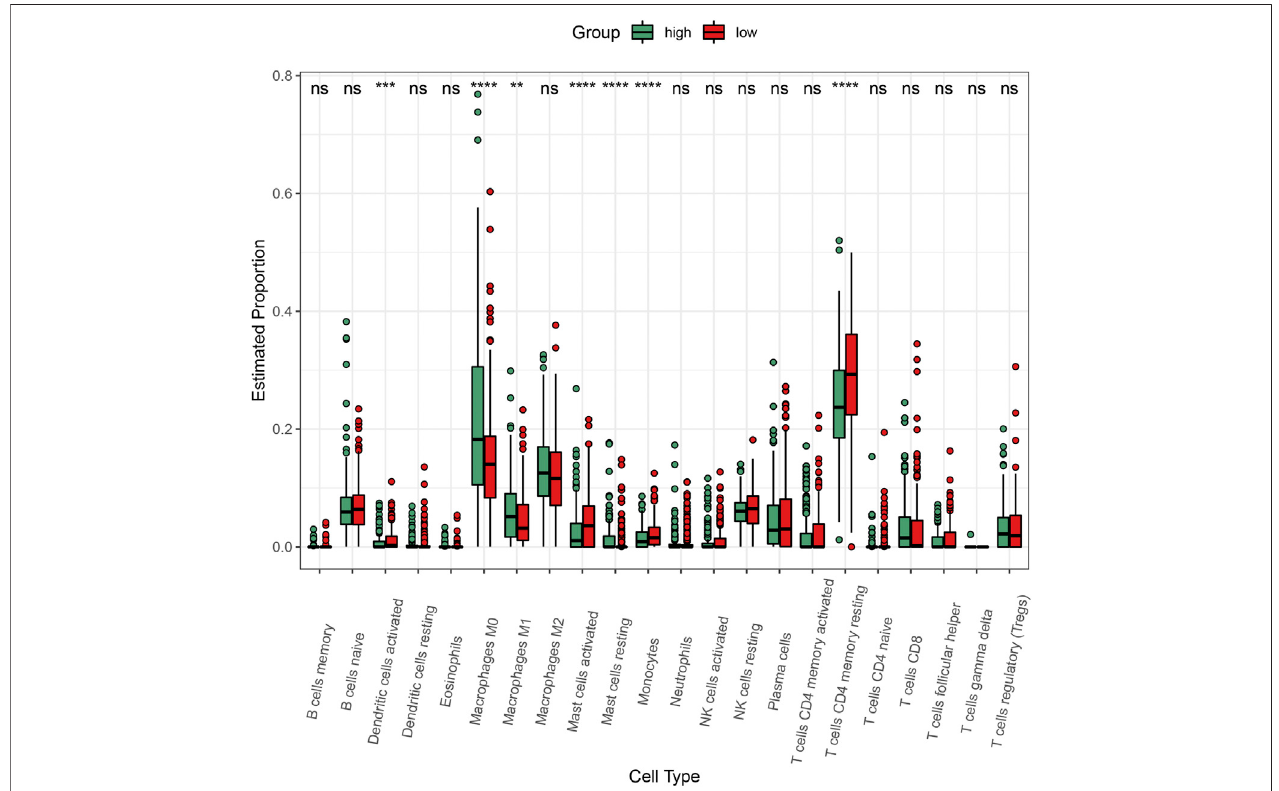
FIGURE 6 | Comparison of the abundance of in fi ltrating immune cells between high-C3 and low-C3 groups in the TCGA-COAD dataset. Samples were categorized according to the median expression level of C3 gene. Kruskal-Wallis test was performed to statistically compare differences. * p < 0.05, ** p < 0.01, *** p < 0.001, **** p <